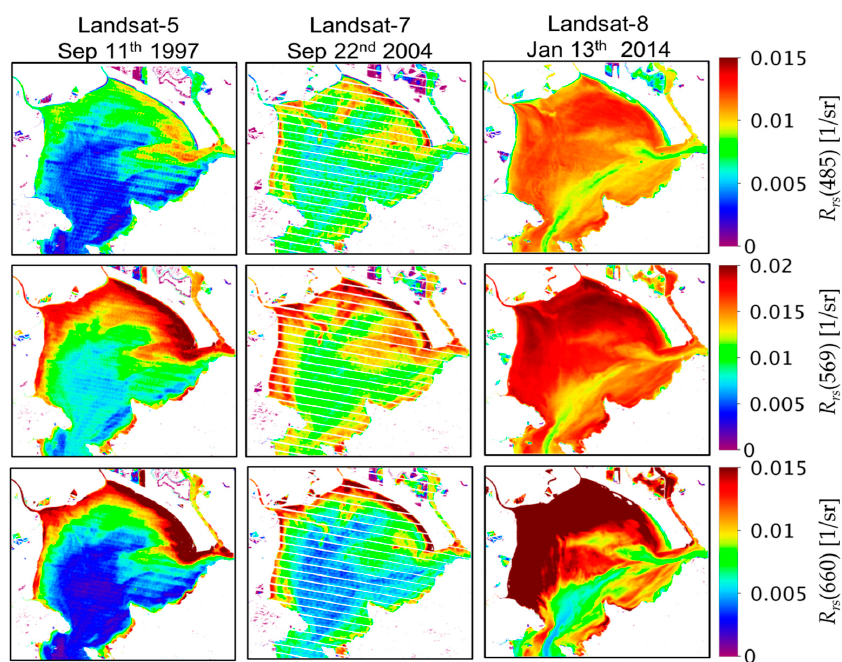
Figure 6. The R rs products derived from TM ( left ), ETM+ ( middle ), and OLI ( right ) over the northern San Francisco Bay area. The band centers shown to the right refer to TM bands. The scan-line corrector issues (i.e., SLC-off) associated with ETM+ retrievals are masked, i.e., white stripes. Varieties of physical phenomena, including upwelling events and sediment resuspensions are captured by heritage Landsat missions. Note that a 7 × 7-element (uniform) averaging filter is applied in the aerosol removal process.